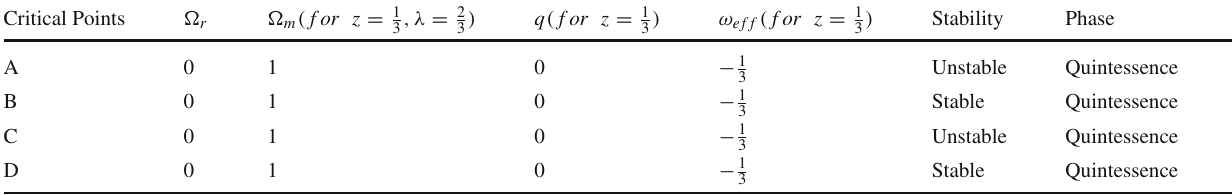
Table 4 Stability conditions, deceleration parameter, density parameters Critical Points